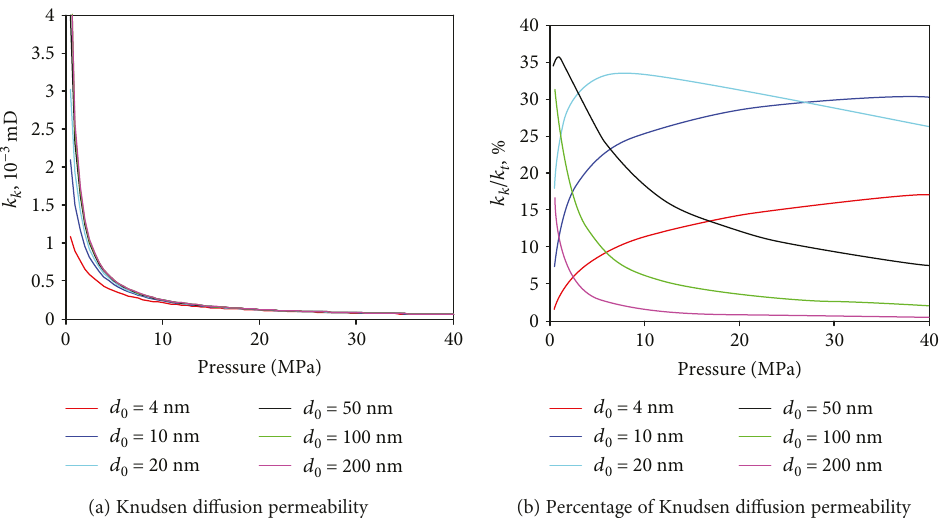
Figure 11: Knudsen di ff usion permeability and its percentage in total apparent permeability.